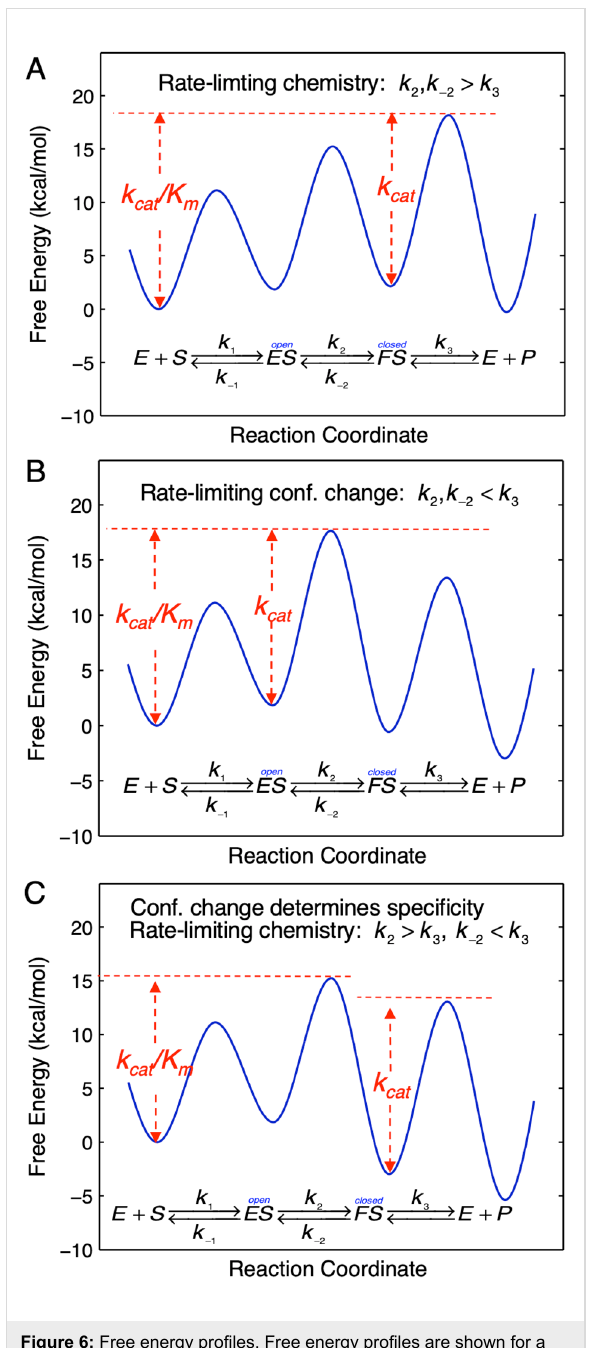
Figure 6: Free energy profiles. Free energy profiles are shown for a three step model with different rate constant relationships as de- scribed in the text and summarized on each figure. The free energy profile was calculated using transition state theory: Δ G ‡ = − RT ·ln( k /( k B T / h )), where k is the rate constant, k B is the Boltz- mann constant and h is Planck’s constant. Second order rate con- stants were converted to pseudo-first order rate constants using an estimated physiological concentration of